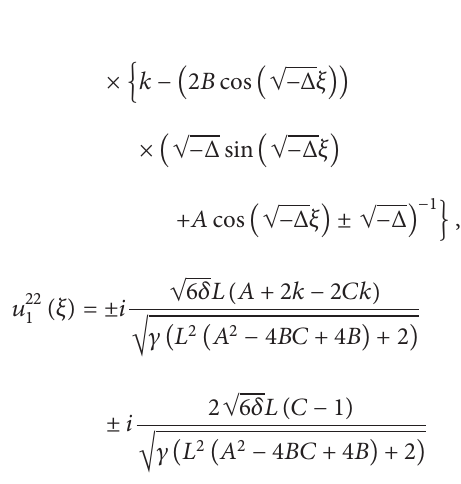
Figure 2: (a)–(d) show the singular solution for 𝑢 2 1 for different values of